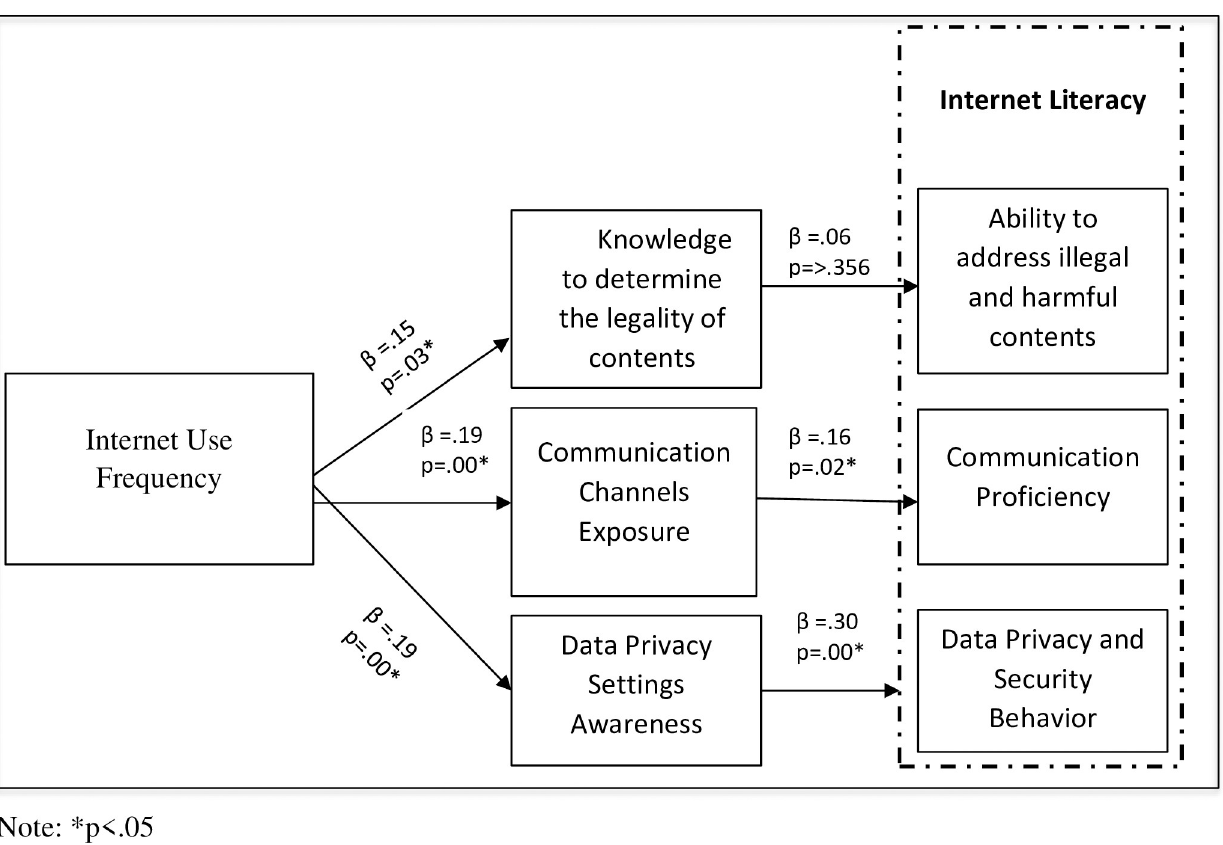
PLOS ONE | https://doi.org/10.1371/journal.pone.0249495 April 20,